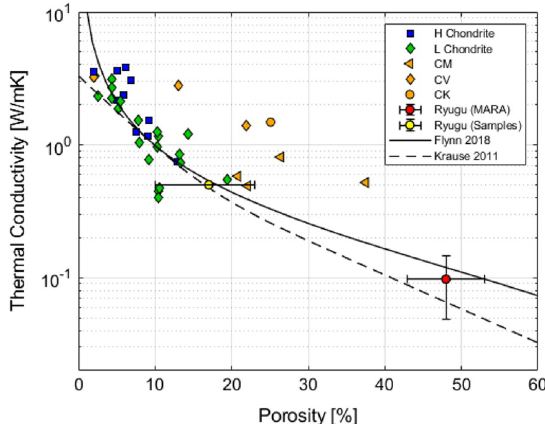
Fig. 6 Thermal conductivity as a function of porosity for different meteorite samples. For reference, the models proposed by Flynn et al. (2018) and Krause et al. (2011) are also shown. Thermal conductivity of the MASCOT rock was estimated based on the analysis of Hamm et al. (2022). Thermal inertia and thermal conductivity relate to each other following Eq. 1. The porosity and thermal conductivity for the Ryugu samples (Nakamura et al. 2022) is